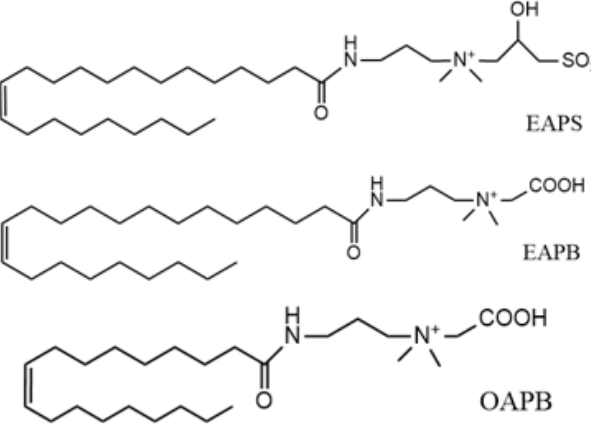
Figure 2. Chemical structures of the surfactants.